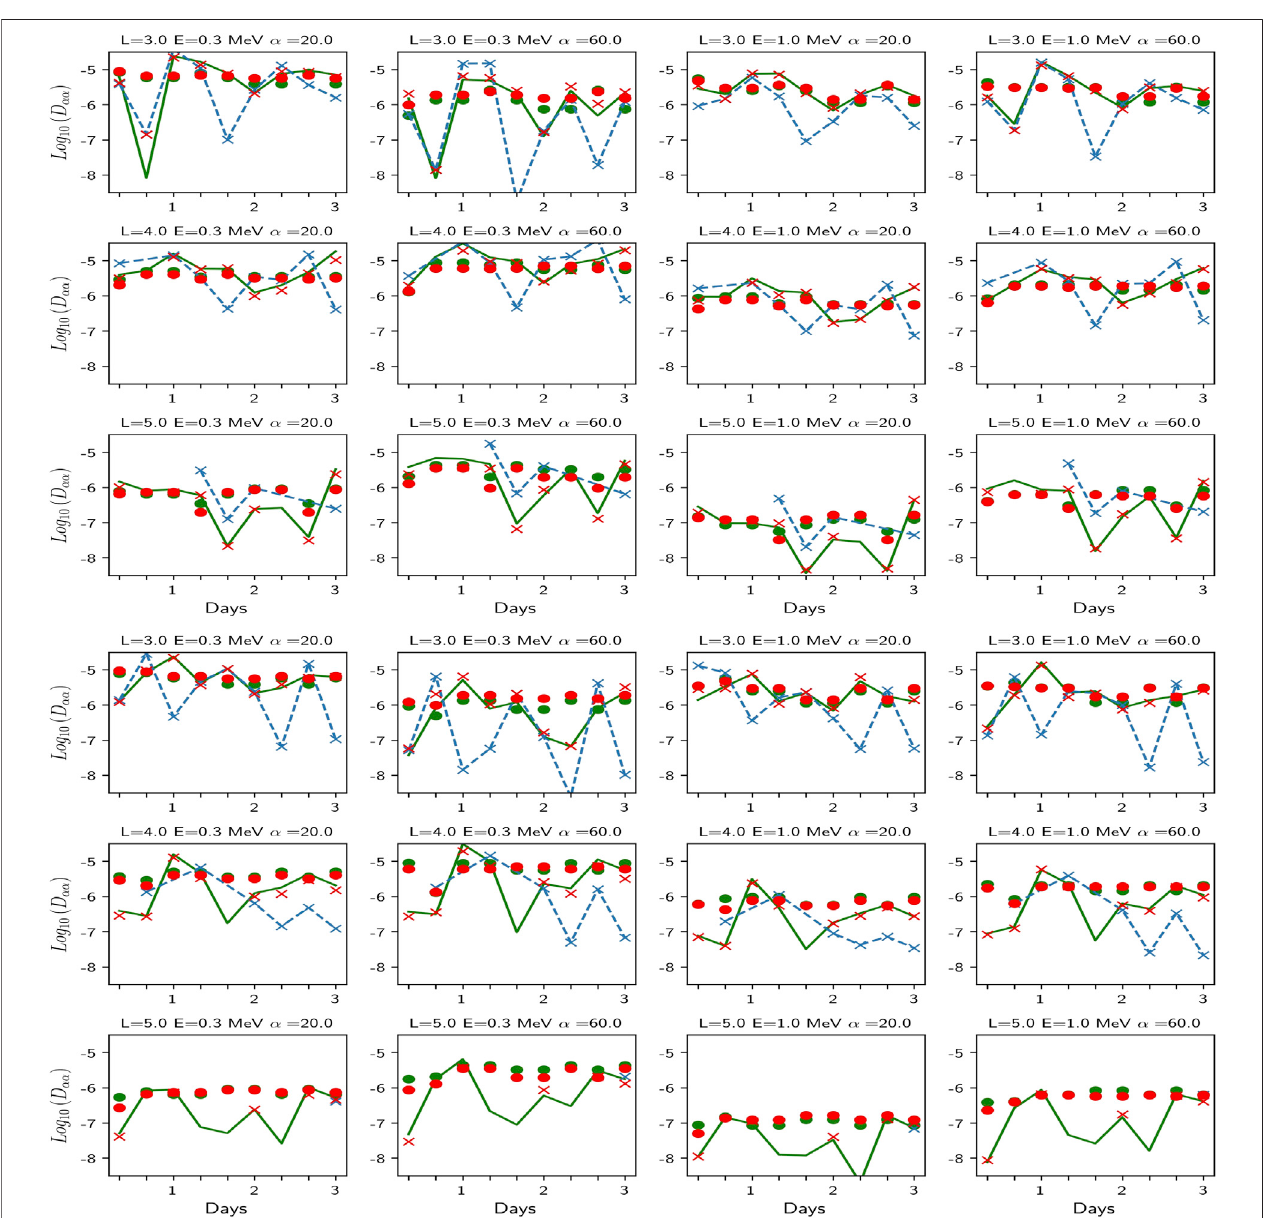
FIGURE8| Historyofthestorms8and5.Weplotherethesameresultsasin Figure5 (blue:rawdata,redcrosses( K p , t , L , E , α )averagemodel,greencrosses( K p , t , L , E , α ) DNN model) to which we added circles obtained from averaging in time either the average data (red) or directly the DNN model (green); it produces a K p - dependent(only)model.TheDNNmodelapproacheswellitstarget(theaveragedata)butbothhaveadegradedaccuracycomparedtotheevent-drivenmodel(inblue), particularly visible for storm 5 in which diffusion coef fi cients depart signi fi cantly from the average.